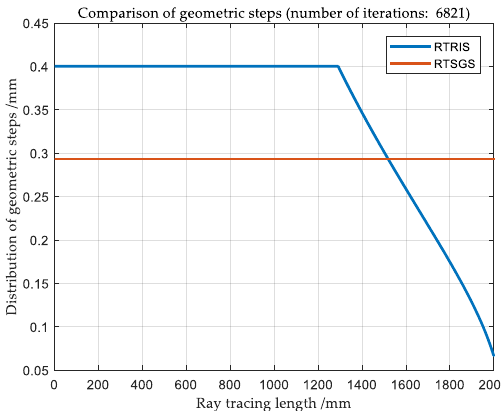
Figure 5. Comparison of geometric steps (number of iterations: 6821).